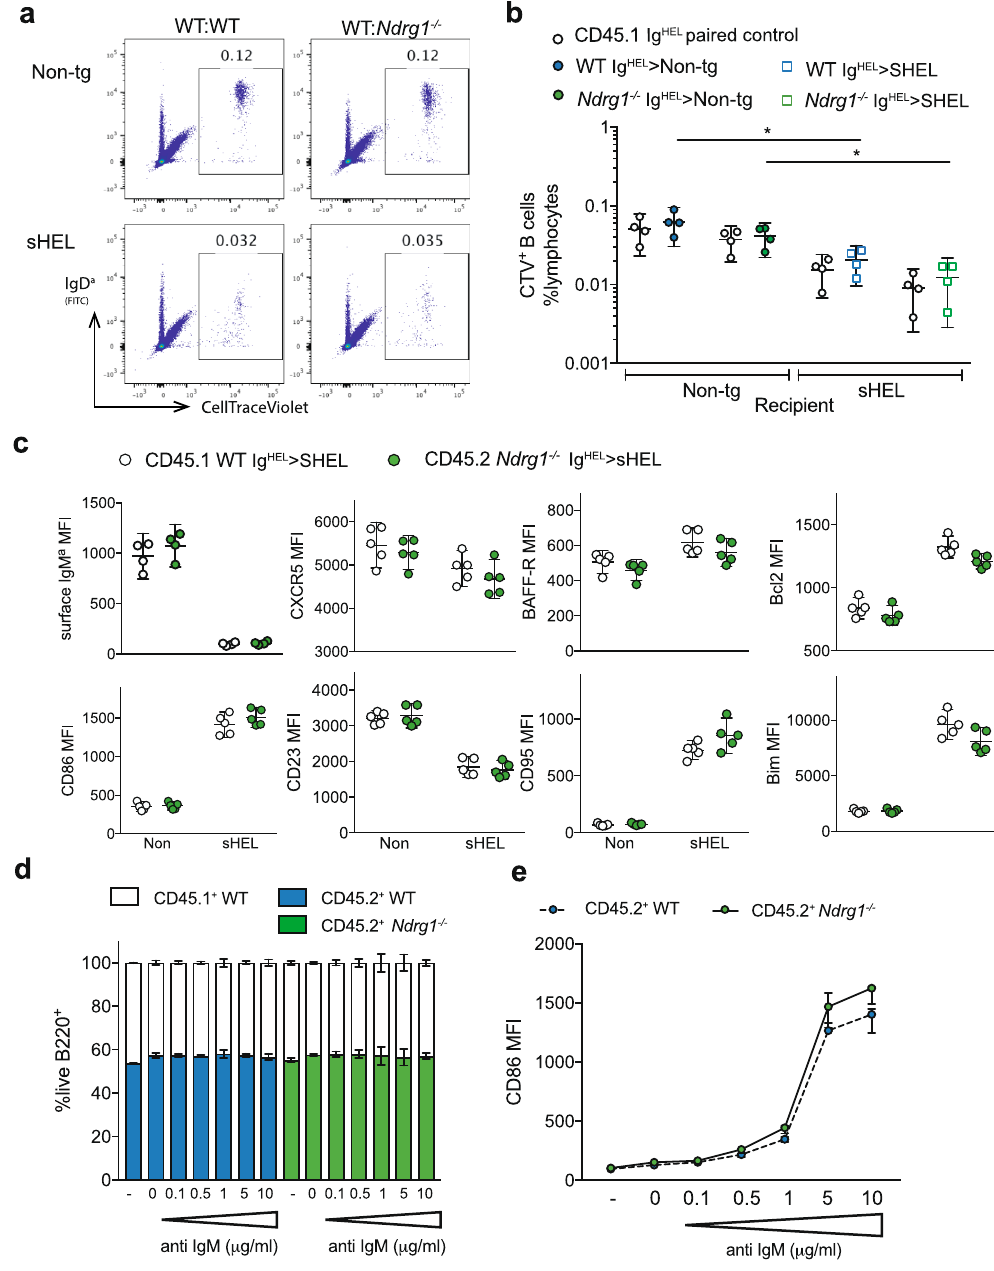
Fig. 6 NDRG1-de fi cient B cells exposed to self-antigen in the periphery are subject to follicular exclusion and cell death. a Representative fl ow cytometry plots of 50:50 mixtures of WT CD45.1 + Ig HEL and WT or Ndrg1 − / − CD45.2 + Ig HEL splenocytes labeled with CTV dye and transferred by i.v . injection into non-tg or sHEL-tg CD45.2 + recipients for 48 h, showing live B220 + CD19 + gated populations and % transferred CTV + cells. b Percentage of total lymphocytes that were either CD45.1 + or CD45.2 + CTV + as gated in (a), with white points showing paired CD45.1 + Ig HEL cells from donor, colored points are CD45.2 + . c MFI of surface marker expression CD86, CD23, CXCR5, IgM a , BAFF-R and CD95, and intracellular Bim and Bcl2, in transferred Ig HEL B cells, gated as in ( a ). Data points are individual mice and lines show means with 95% CI error bars and data are representative from 1 to 3 independent experiments with 4 – 6 mice per group. d , e Ratio of B220 + cells surviving from 50:50 mixtures of WT CD45.1 + and WT or Ndrg1 − / − CD45.2 + non-tg B cells stimulated with anti-IgM at the indicated concentrations for 16 h at 37 °C ex vivo ( d ) and CD86 surface expression as MFI on the CD45.2 + B220 + cells ( e ). Data are representative of 3 independent experiments with columns or circles as means with 95% CI error